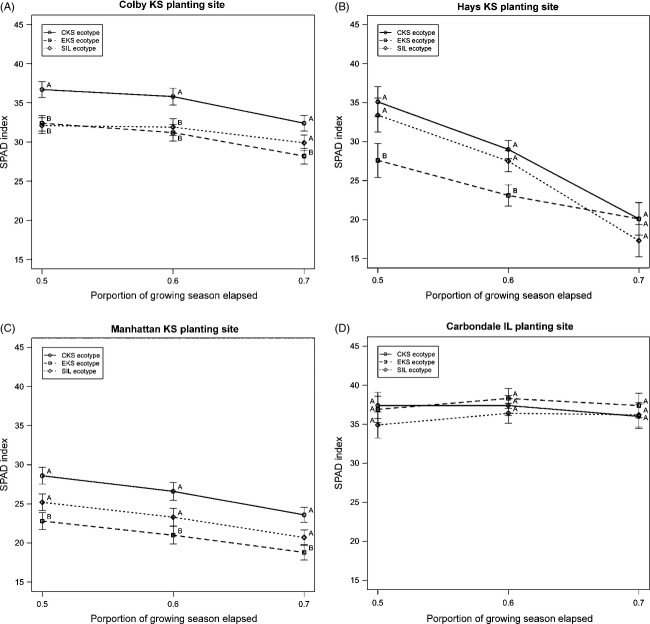
SPAD index values (least squares mean estimates ± SE) for selected ecotypes plotted over proportion of the growing season elapsed at each planting site (Colby, Hays, and Manhattan, KS and Carbondale, Illinois). Higher numbers reflect higher chlorophyll content. CKS = central KS ecotype (circle), EKS = eastern KS ecotype (square), SIL = southern Illinois ecotype (diamond). A, B letters indicate significant differences between ecotypes within a planting site and at a given stage of the growing season.